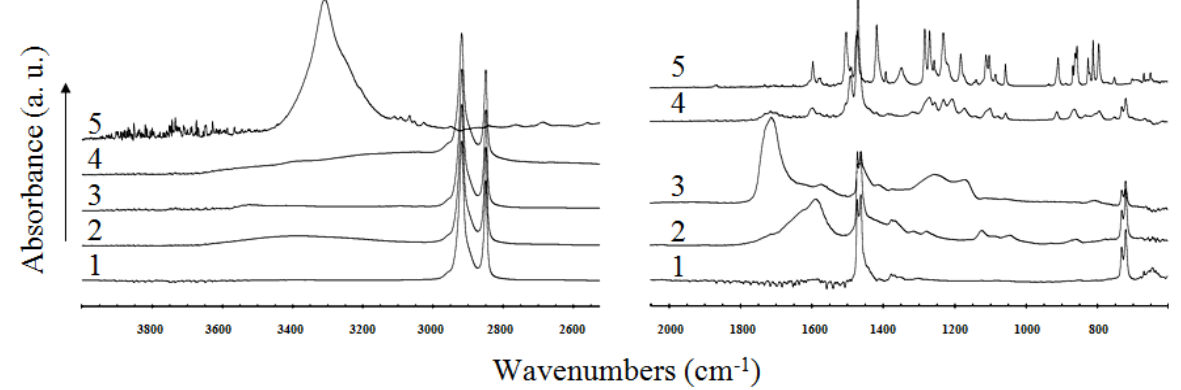
Figure 5. FT-IR-ATR spectra of: 1 - untreated LDPE; 2 - plasma treated; 3 - AA grafted; 4 - triclosan coated; 5 - pure triclosan.